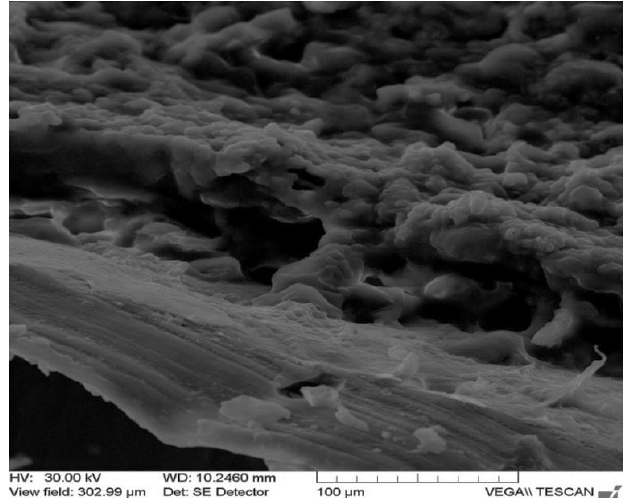
Figure 2. Detail of the previous image (Figure 1c), with increased magnification: the osteoblasts seized in the osteine oriented in traverses (Sealapex) are noteworthy.